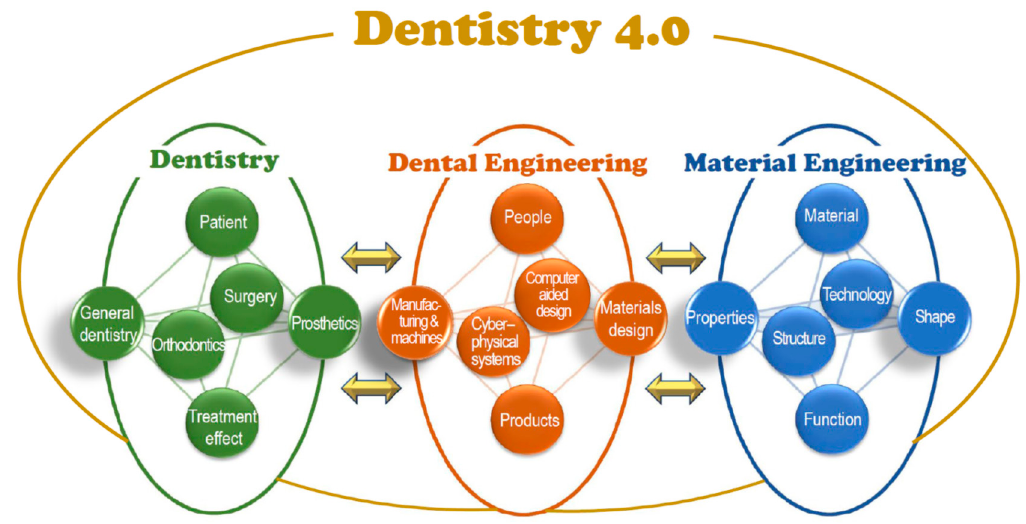
Figure 1. General diagram of the synergistic relationships between dentistry, dental engineering and materials engineering in the Dentistry 4.0 model.